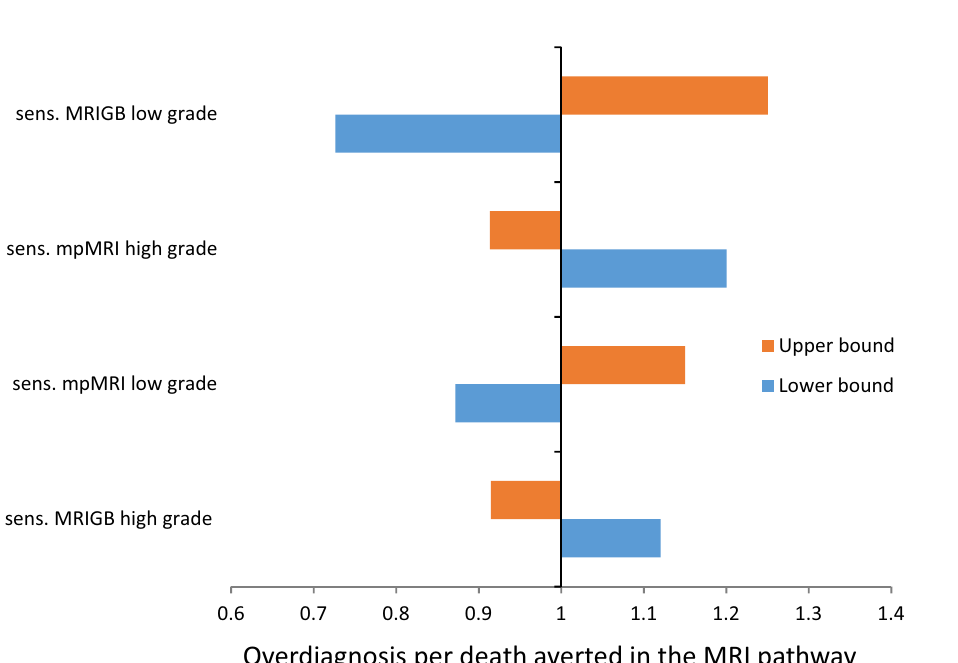
Figure 2. Tornedo diagram of one-way sensitivity analysis on the harm-benefit ratio (over diagnosis per cancer death averted) for the MRI pathway. sens.MRIGB low grade- sensitivity of magnetic resonance imaging-guided biopsy for low grade prostate cancer; sens.MRIGB high grade- sensitivity of magnetic resonance imaging- guided biopsy for high grade prostate cancer; sens.mpMRI low grade- sensitivity of multi-parametric magnetic resonance imaging for low grade prostate cancer; sens.mpMRI high grade- sensitivity of multi-parametric magnetic resonance imaging for high grade prostate